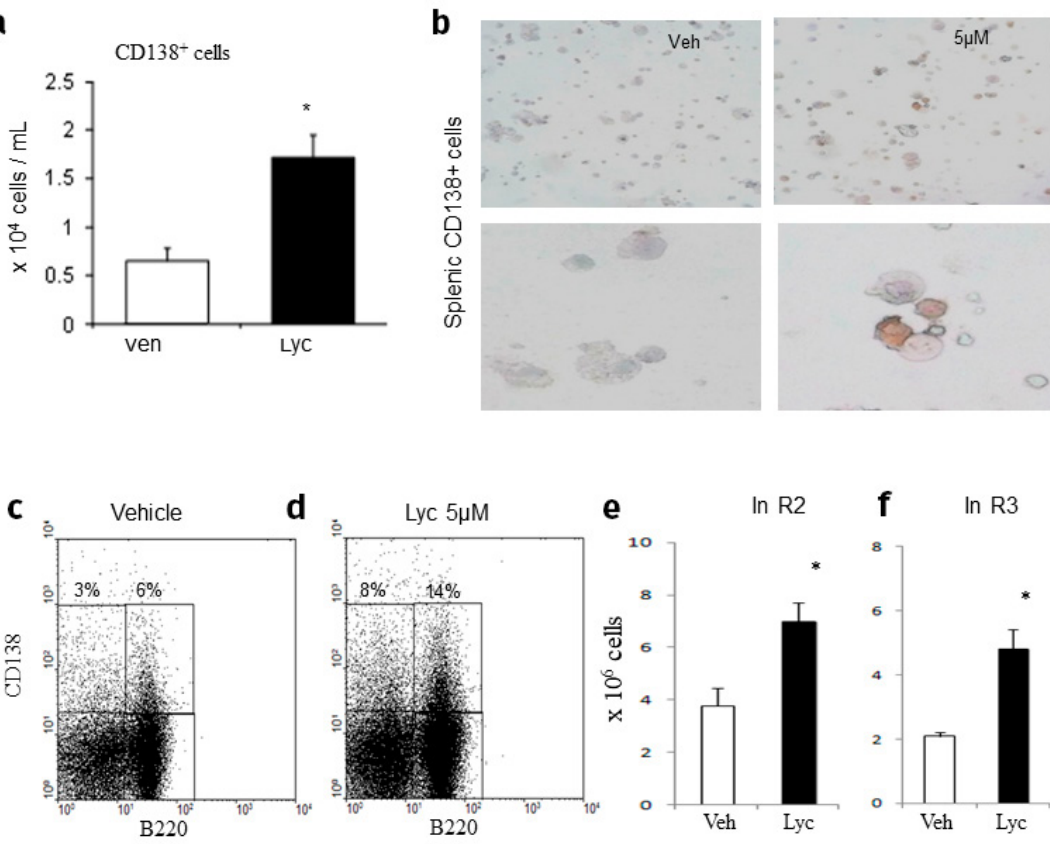
Figure 4. Splenic B cell differentiation induced by lycopene. Splenic cells cultured in the absence (a, control) and in contact with lycopene 5uM (a, Lyc) were quantified after 5 days of culture. (b) Immunocytochemistry essay revealed CD138 + cells numerically increased after lycopene supplementation in vitro . B220 + CD138 + cells (plasmablasts) and B220 - CD138 + cells (plasma cells) were quantified in control (c) and lycopene supplementation condition (d). The absolute number was defined according previous phenotype: Plasmablasts (e) and plasma cells (f). n=5 mice per group. * indicates